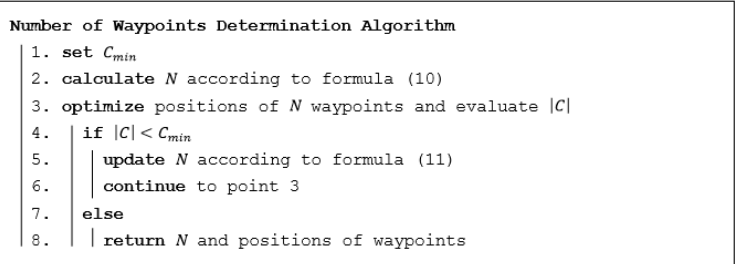
Figure 4. Algorithm for determining the number of waypoints.